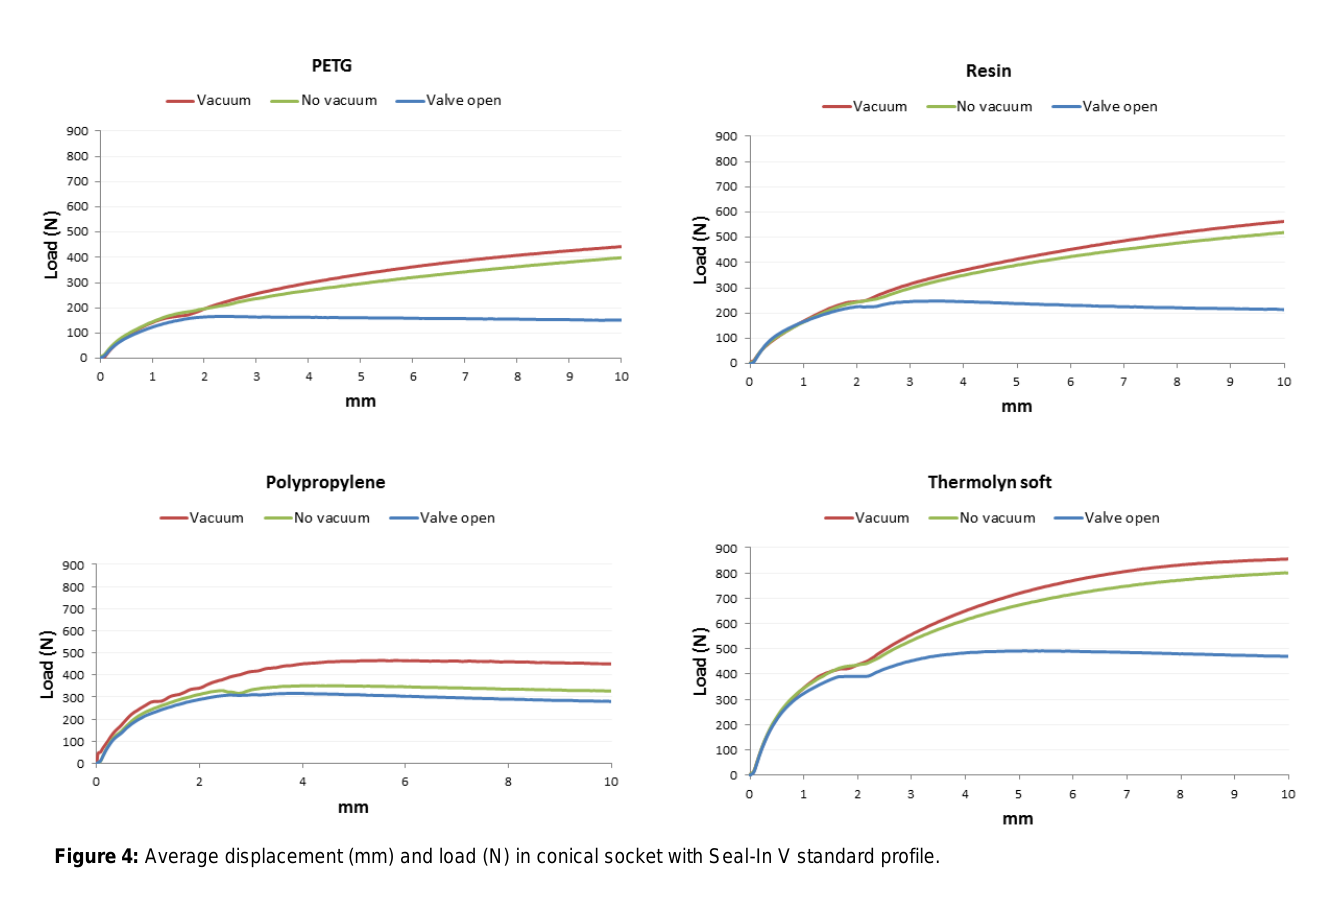
Figure 4: Average displacement (mm) and load (N) in conical socket with Seal-In V standard profile.